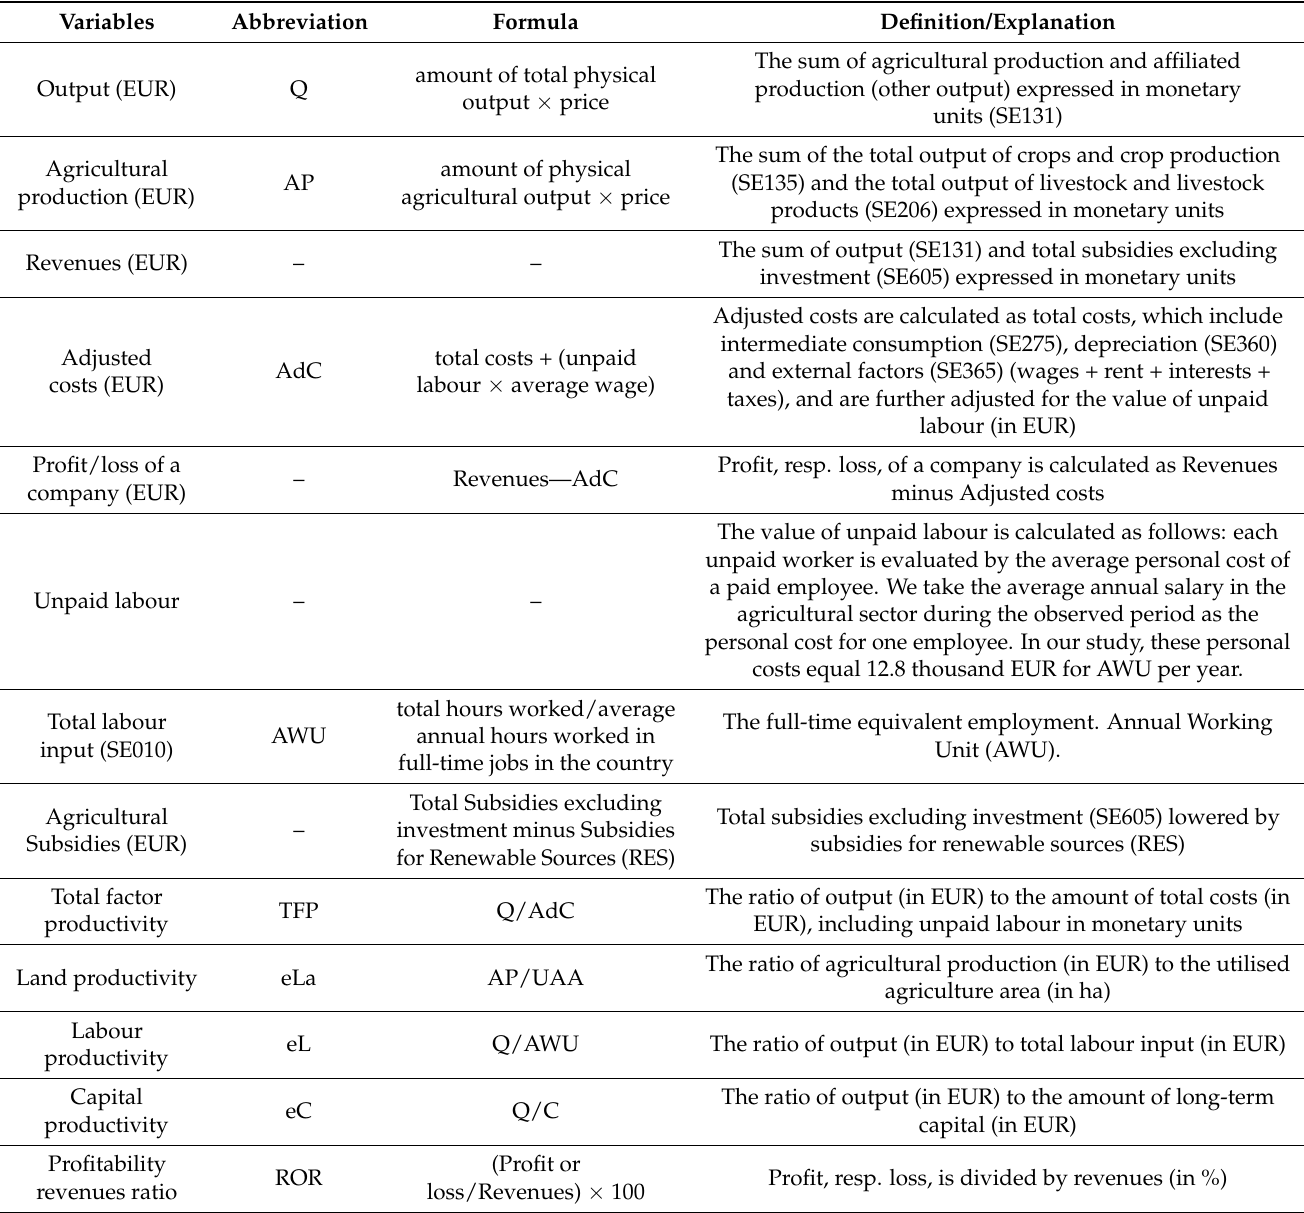
Table 1. List of